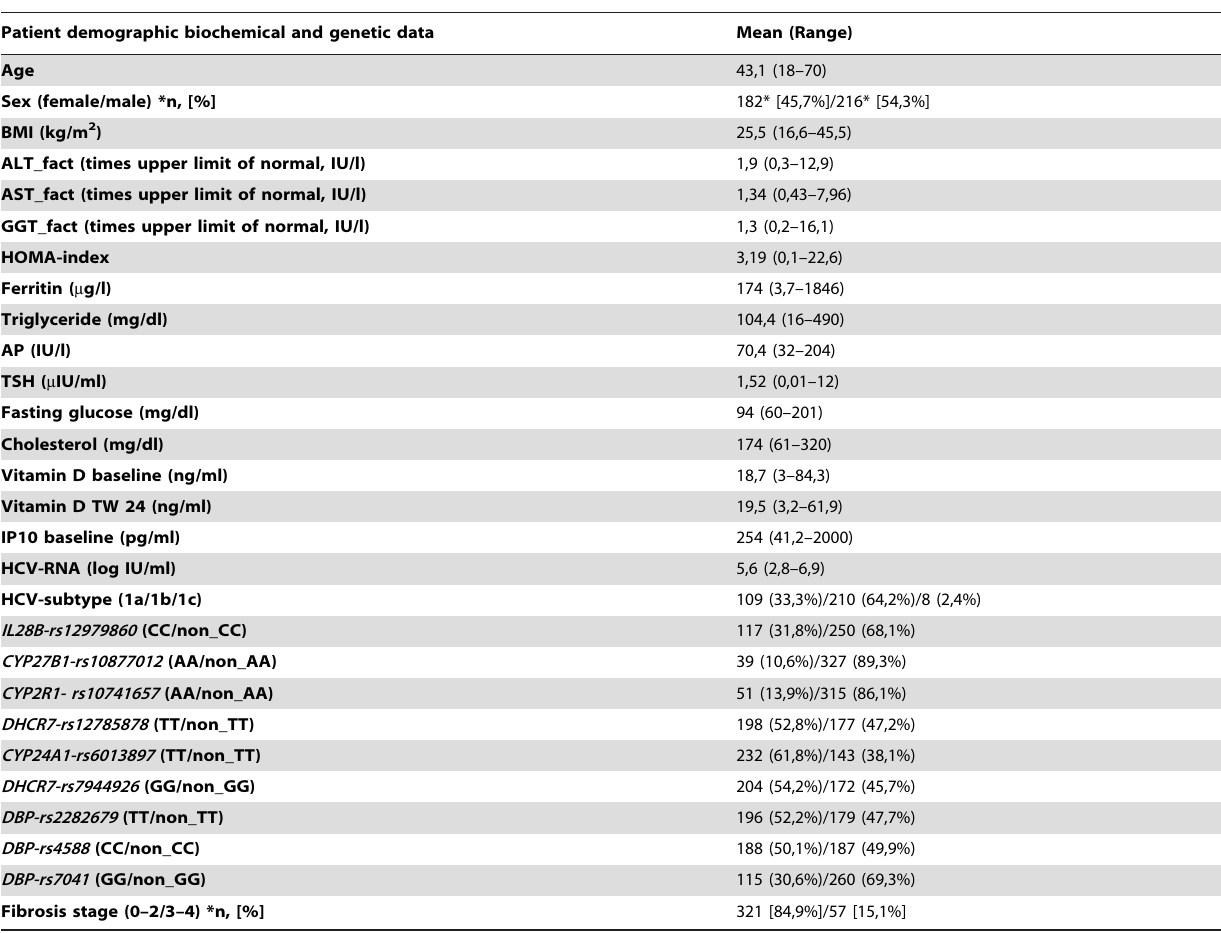
Table 1. Patient demographic, biochemical and genetic characteristics.